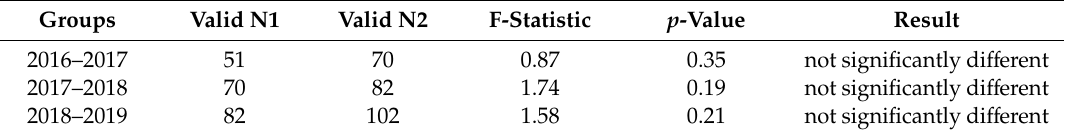
Table 4. The proof of the equality of